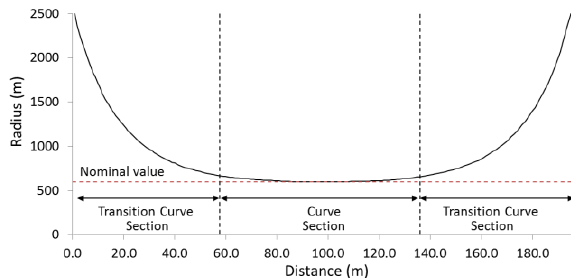
Figure 15. The relationship between distance and curve radius in curve